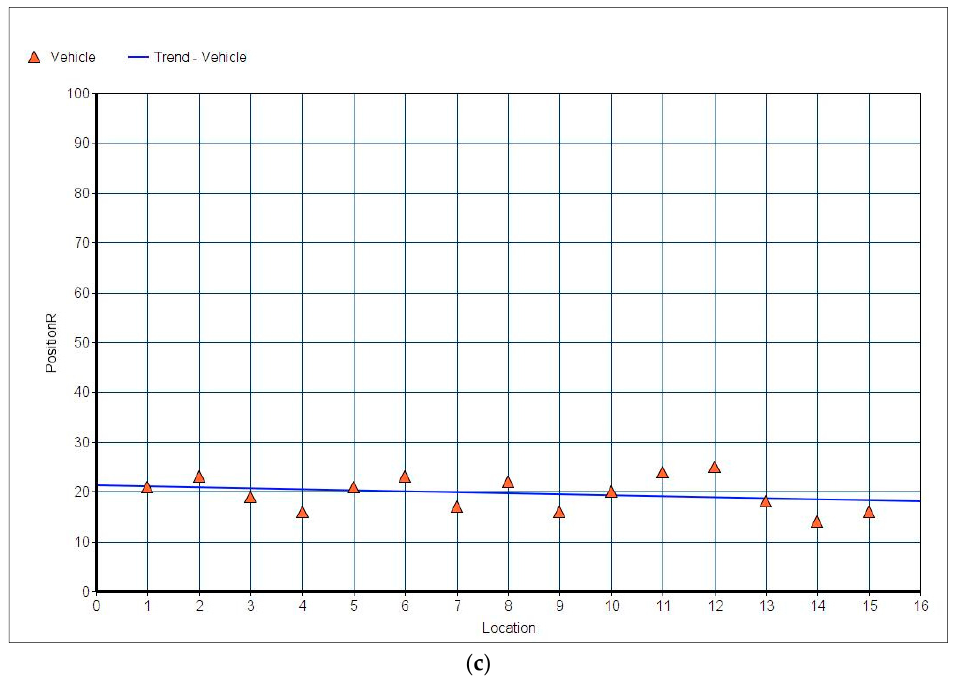
Figure 9. ( a ) PositionR of vehicles in normal conditions. ( b ) PositionR of vehicles in normal conditions with 50% vehicle attacks. ( c ) PositionR of vehicles in normal conditions with 50%.